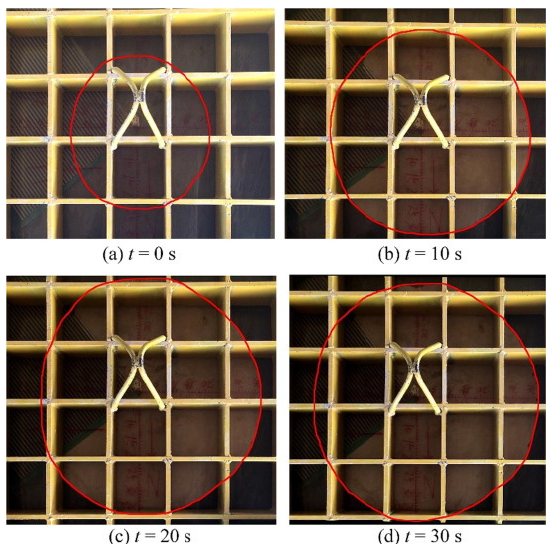
Figure 4. Change in flow-field pressure and grout diffusion morphology with time. ( a ) The end of the static pressure injection stage was set as the initial time (0 s) at which the initial diffusion radius was defined. ( b ) The shape of grout diffusion for 10 s. ( c ) The shape of grout diffusion for 20 s. ( d ) The shape of grout diffusion for 30 s. Scale bar is 0.1 cm. Reproduced from [45], with permission from Elsevier, 2021.